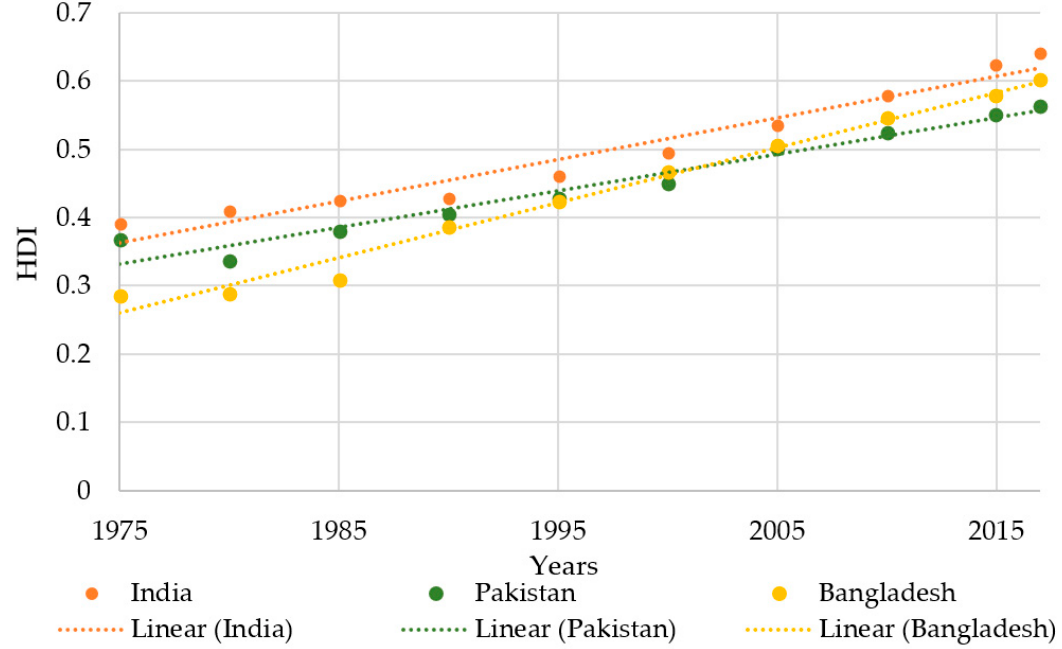
Figure 20. HDI Comparison of IPB shows a linear trend for each of IPB countries with Bangladesh having the highest rate in increase. having the highest rate in